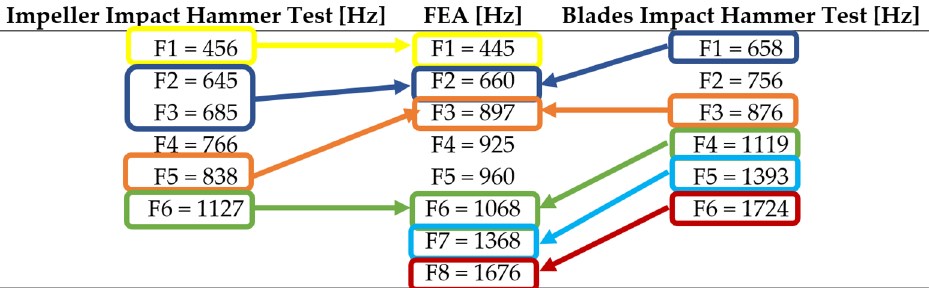
Table 6. Correlation between the maximum relative deviations of the Eigen frequencies determined experimentally and by numerical simulations.